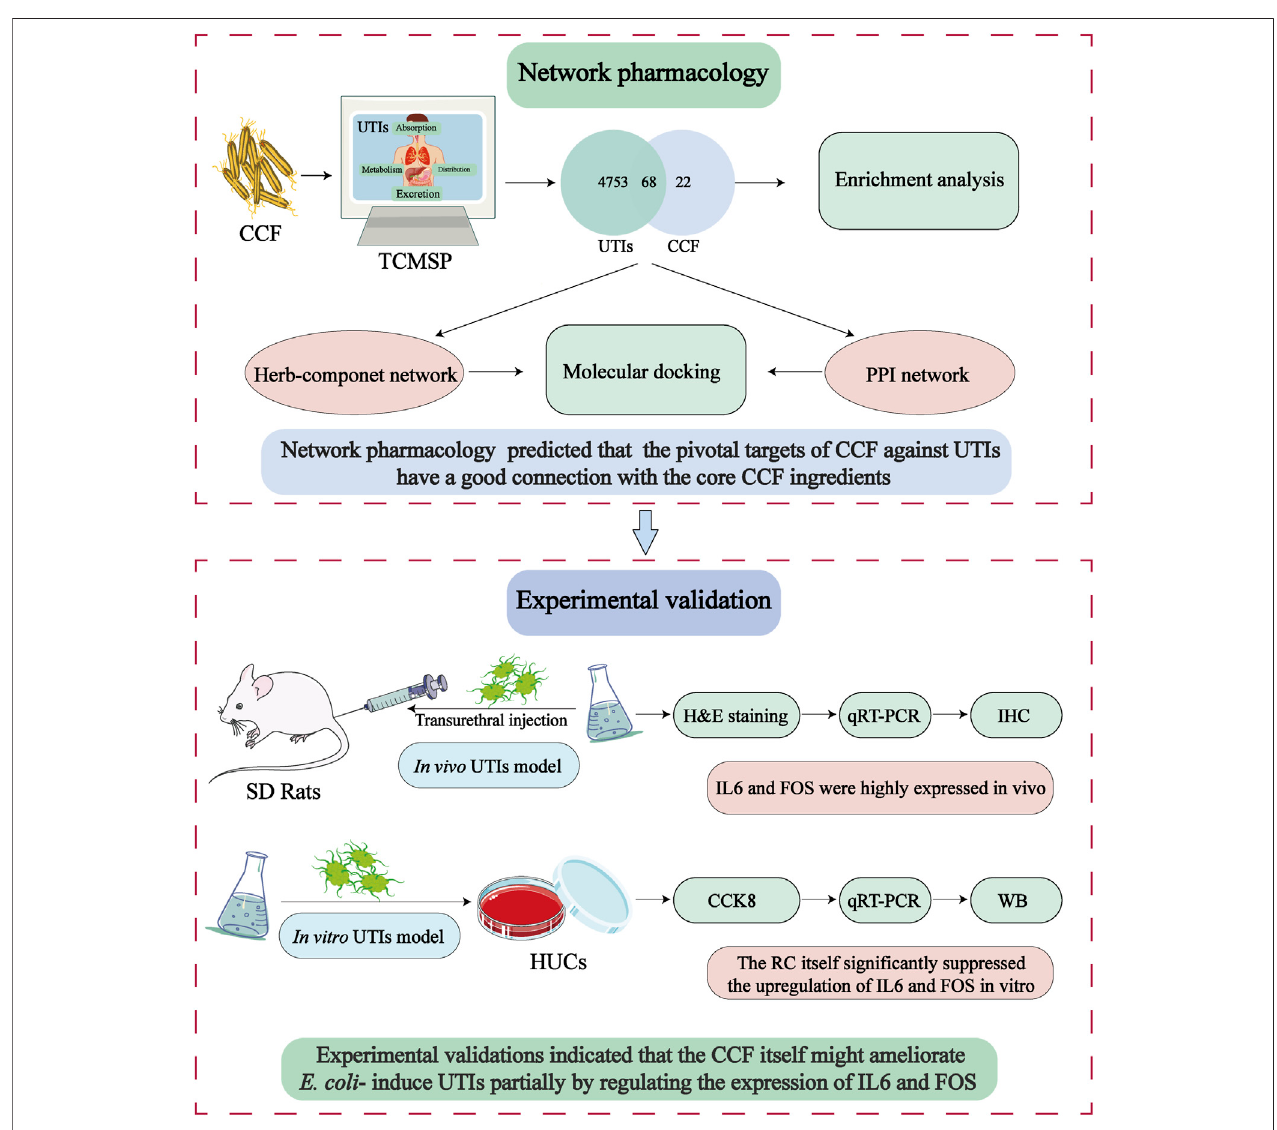
FIGURE 1 | System-pharmacology work fl ow for the analysis of CCF against UTIs.